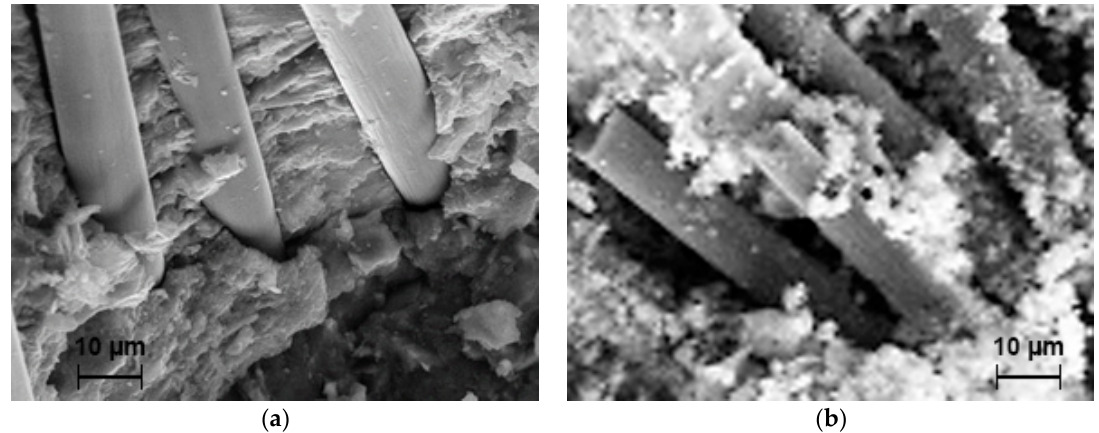
Figure 7. SEM images of mortars containing ( a ) VCF and ( b ) RCF.